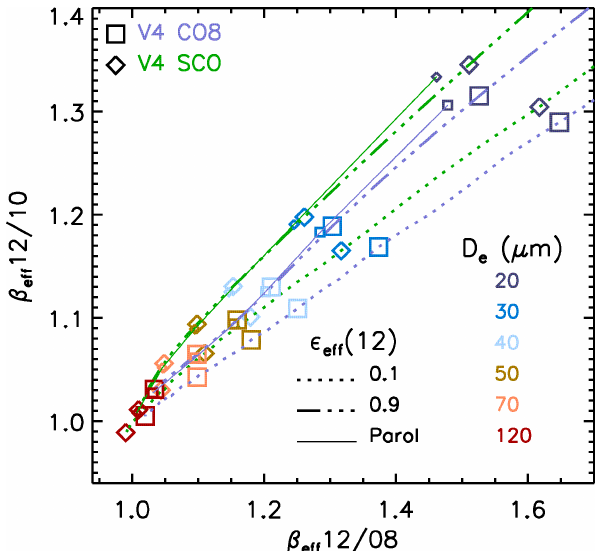
Figure 11. The V4 ice LUT values (solid lines; CO8: large squares; SCO: large diamonds) are compared with the V4 LUT values with no PSD (dashed–dotted lines and small symbols) and the V3 ice LUT values (dashed lines; cross: aggregate; plus signs: solid col- umn) for six values of D e between 20 and 120µm and using ε eff , 12 = 0 . 23 for the three